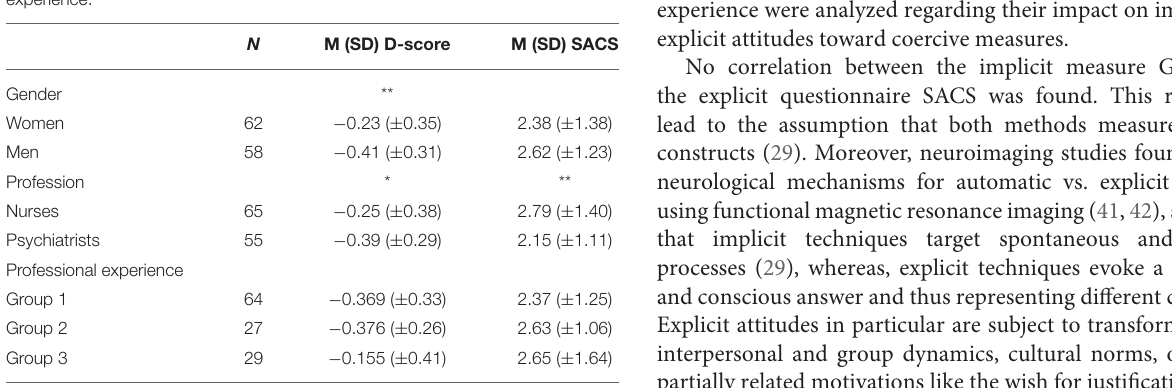
TABLE 2 | Descriptive statistics and group comparisons of implicit (GNAT) and explicit (SACS) measures regarding gender, profession, and professional